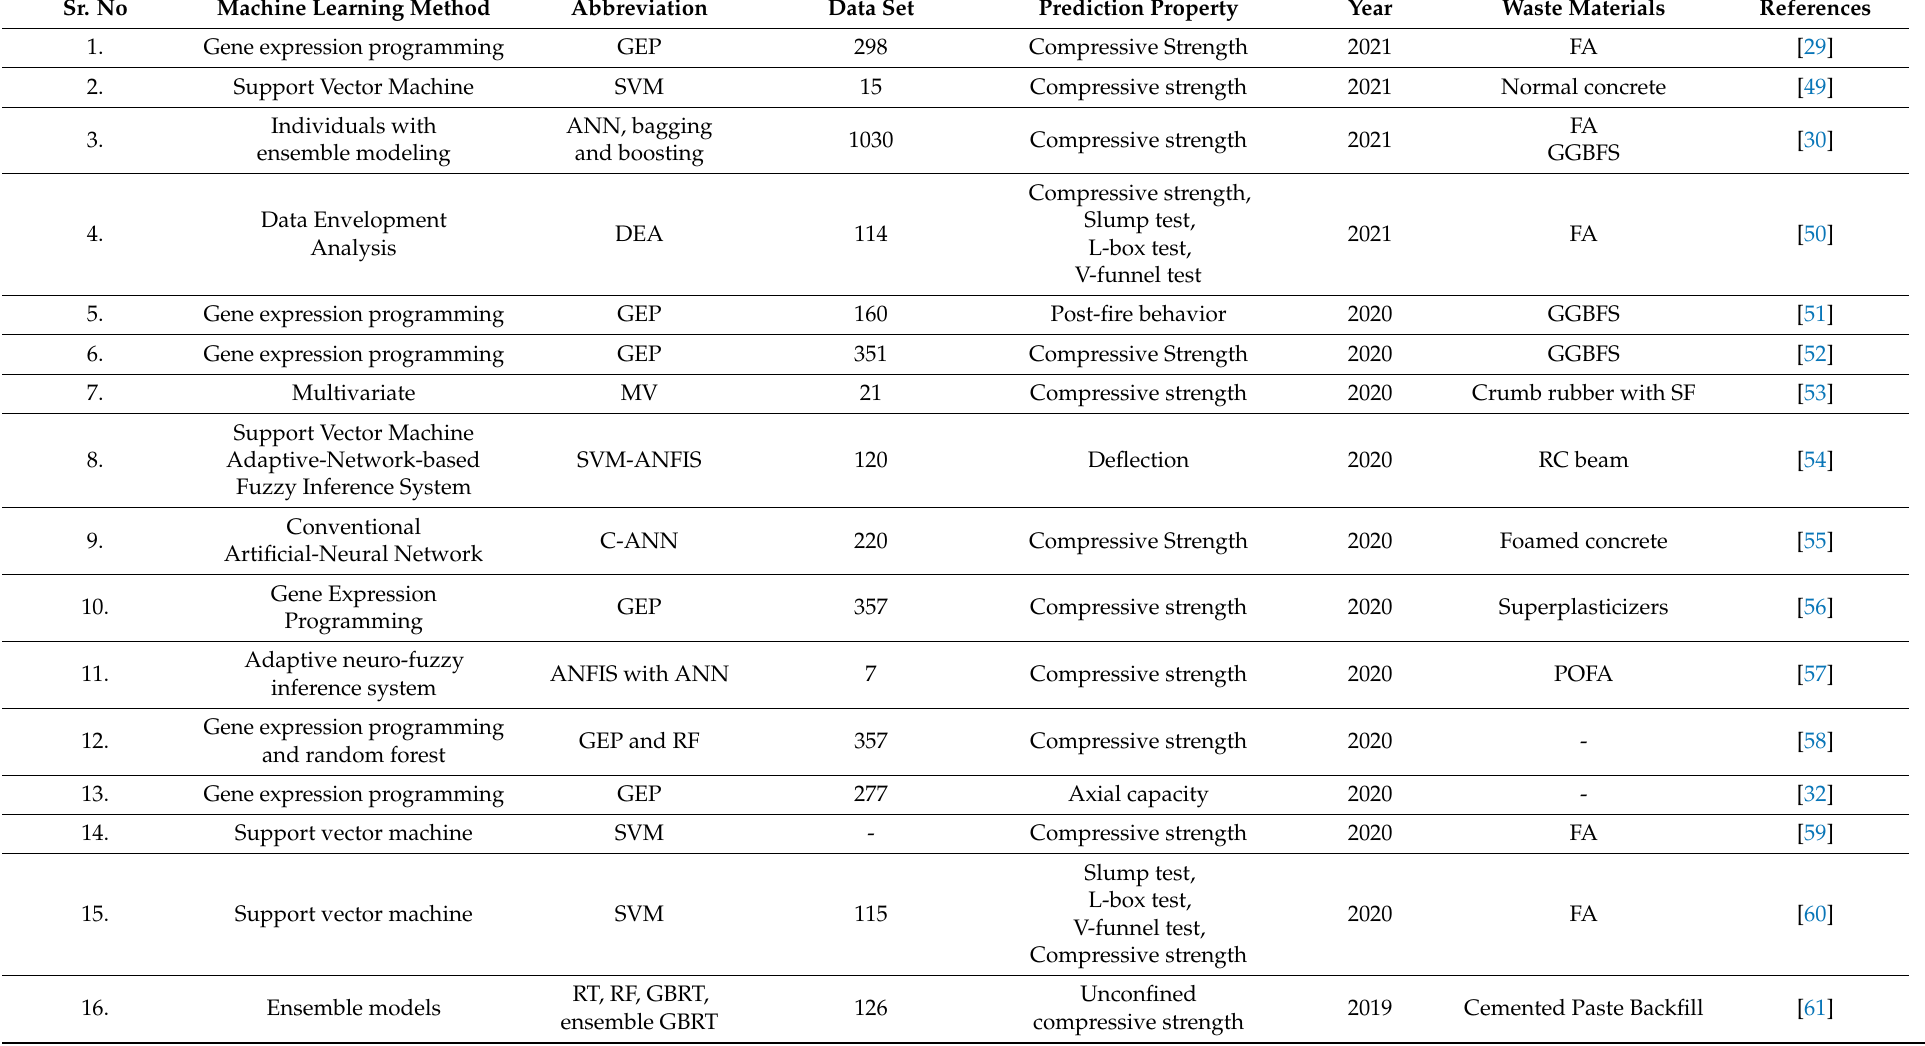
Table 3. Summarize machine-learning algorithm by